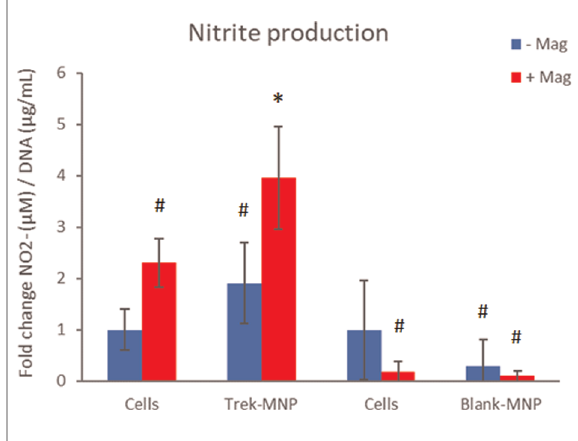
FIGURE 4 TREK-MNP induce NO signalling in SH-SY5Y. Nitrite prduction was assayed using the Greiss assay. Treatment with TREK-MNP plus magnetic fi eld stimulation resulted in a 4-fold increase in Nitrite production whilst uncoated (Blank-MNP) had no effect on Nitrite production. n =3-4, bars represent mean fold change, * represents p <0.05, # represents p >0.05 (2-way